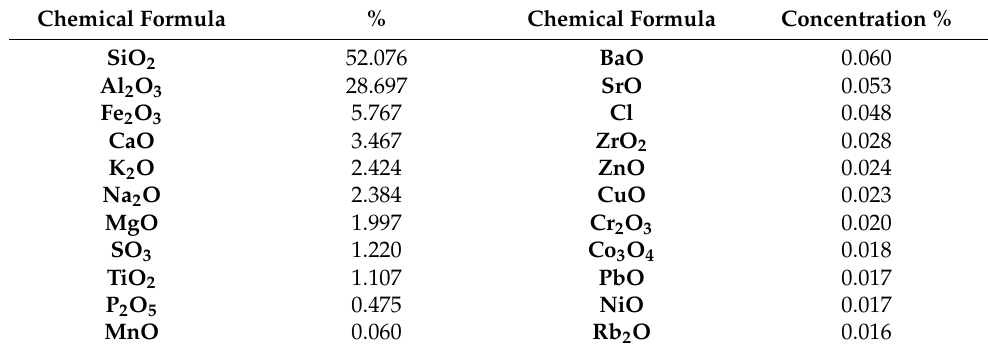
Table 1. Oxygen composition of FA.